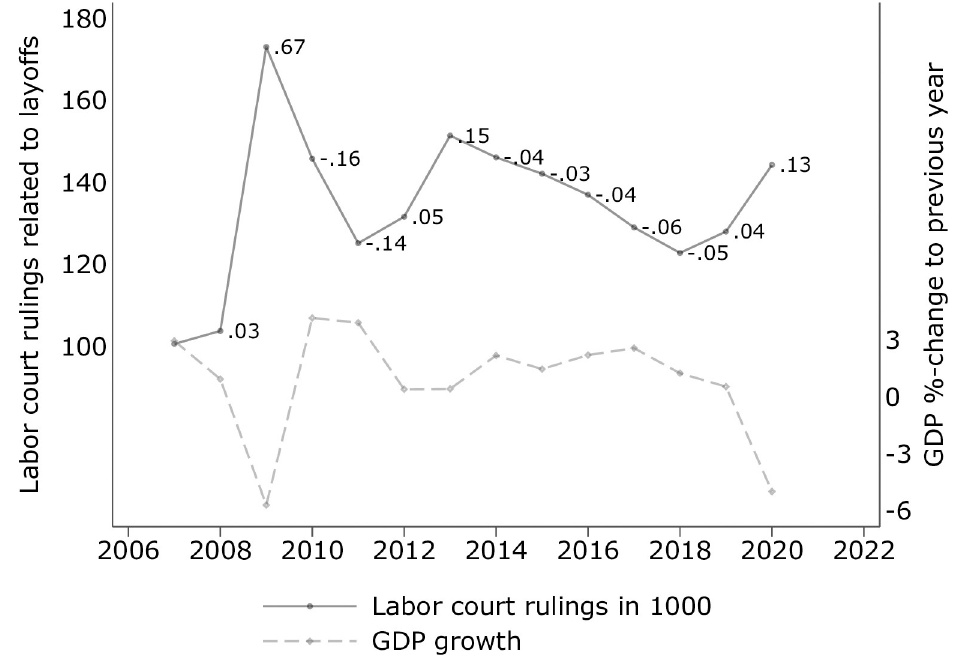
Fig 5. Labor court rulings and economic growth. Note: Fig presents the development of German labor court rulings dealing with layoffs over time and compares these numbers with GDP growth. Source: Federal Office of Statistics [99], own